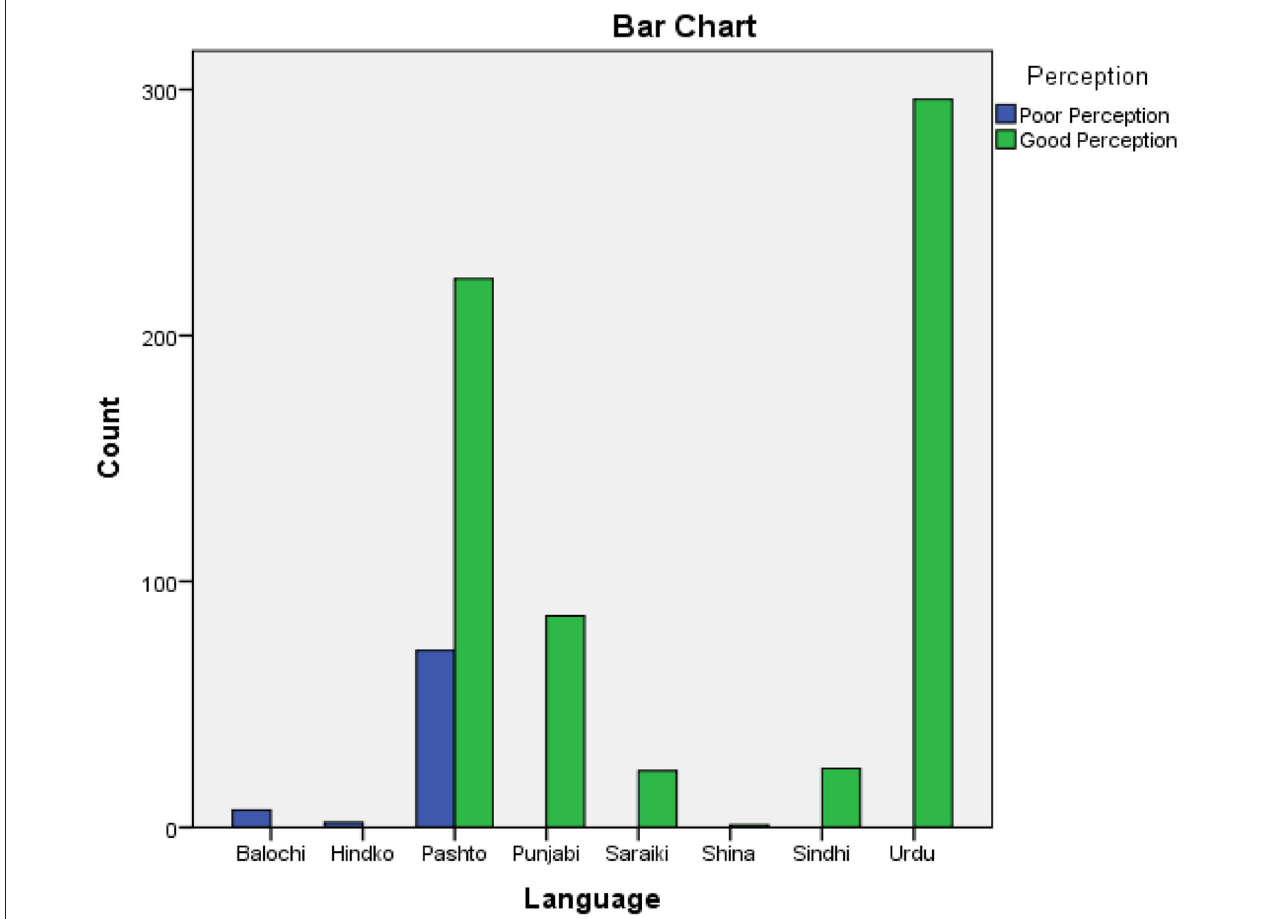
FIGURE 2 | Language-based response of participants to